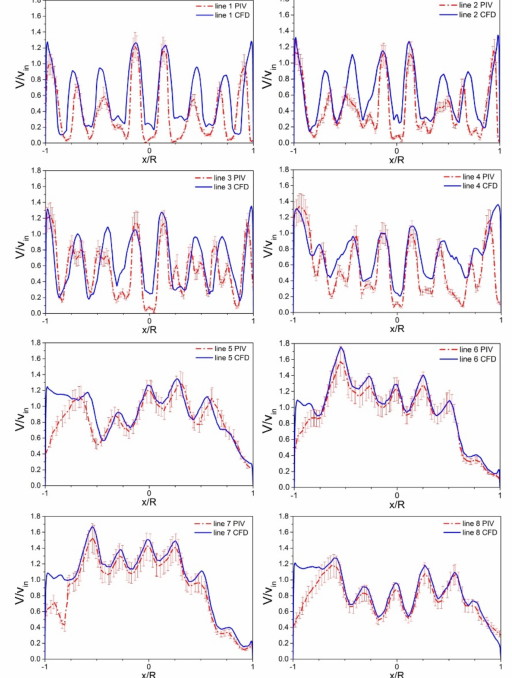
Figure 14. Comparison of velocity profiles derived by CFD method and gained from PIV for Q = 5 m 3 /